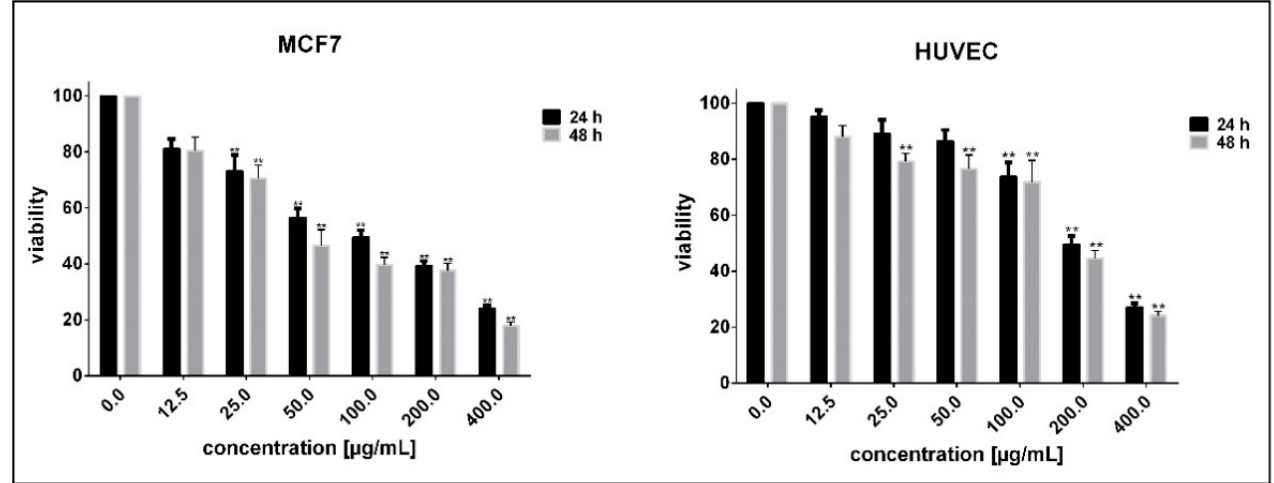
Figure 4. Time- and concentration-dependent toxicity of CoNiZn NPs on Michigan Cancer Foundation-7 (MCF7) and human umbilical vascular endothelial cells (HUVEC) using MTT colorimetric assay following 24 and 48 h incubation. Data are expressed as mean ± SD from one representative of three independent experiments. (** p < 0.05 compared with untreated